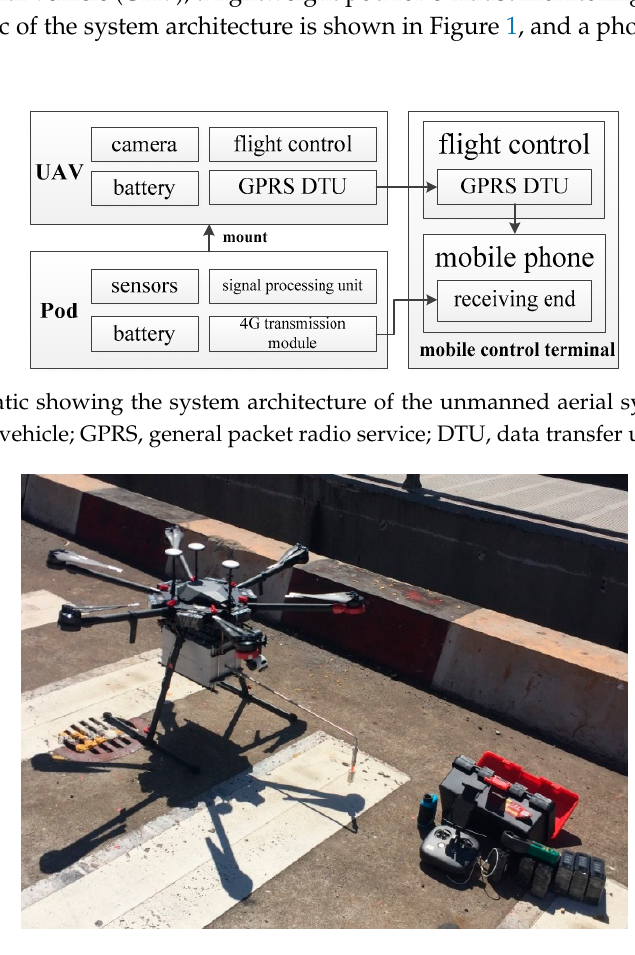
Figure 2. Photograph of the unmanned aerial system used in the present study.